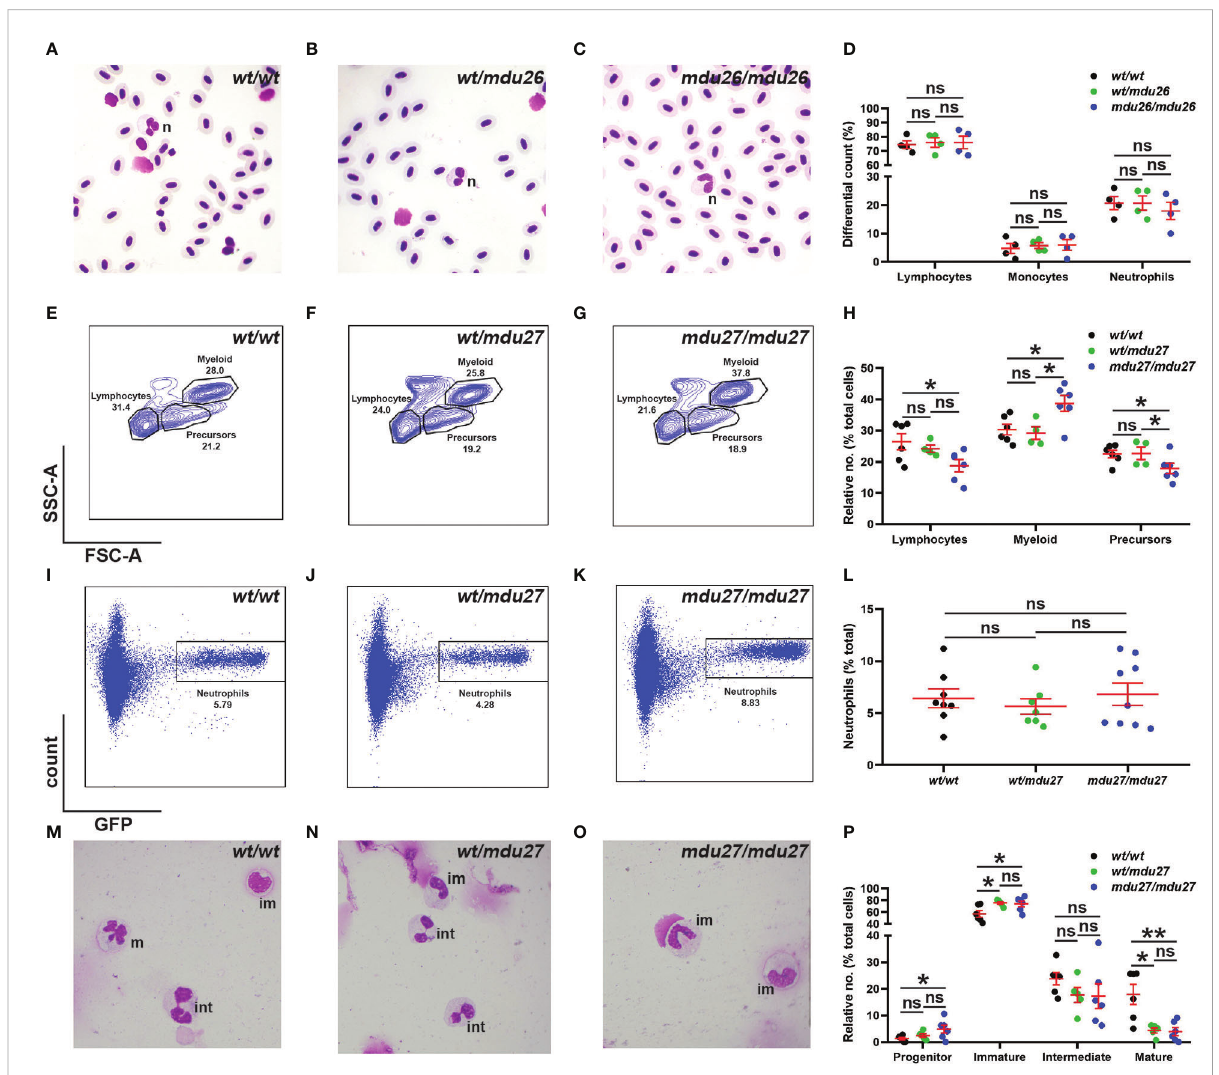
FIGURE 4 Effect of G-CSFR truncation mutation on adult hematopoiesis. (A – D) . Adult blood cells from wild-type ( wt/wt ), heterozygous ( wt/mdu26 ) and homozygous ( mdu26/mdu26 ) mutant csf3r fi sh were subjected to Giemsa-staining (A – C) , along with differential quantitation of the indicated blood cell populations for individual fi sh (D) , with mean and SEM shown in red and level of statistical signi fi cance indicated (ns: not signi fi cant; n=4). Abbreviation: n: neutrophil. (E – P) . Adult kidney cells from wild-type ( wt/wt ), heterozygous ( wt/mdu27 ) and homozygous ( mdu27/mdu27 ) mutant csf3r fi sh on a Tg( mpo::GFP ) background were subjected to FACS analysis using SSC/FSC (E – G) and GFP fl uorescence (I – K) , along with quantitation of indicated cell populations (H) and GFP+ neutrophils (L) , with sorted GFP+ cells subjected to Giemsa-staining (M – O) , along with differential quantitation of relative differentiation (P) . Panels (H, L, P) display results for individual fi sh, with mean and SEM shown in red and level of statistical signi fi cance indicated (*: p < 0.05, ns: not signi fi cant; n=4-9). im, immature; int; intermediate; m,